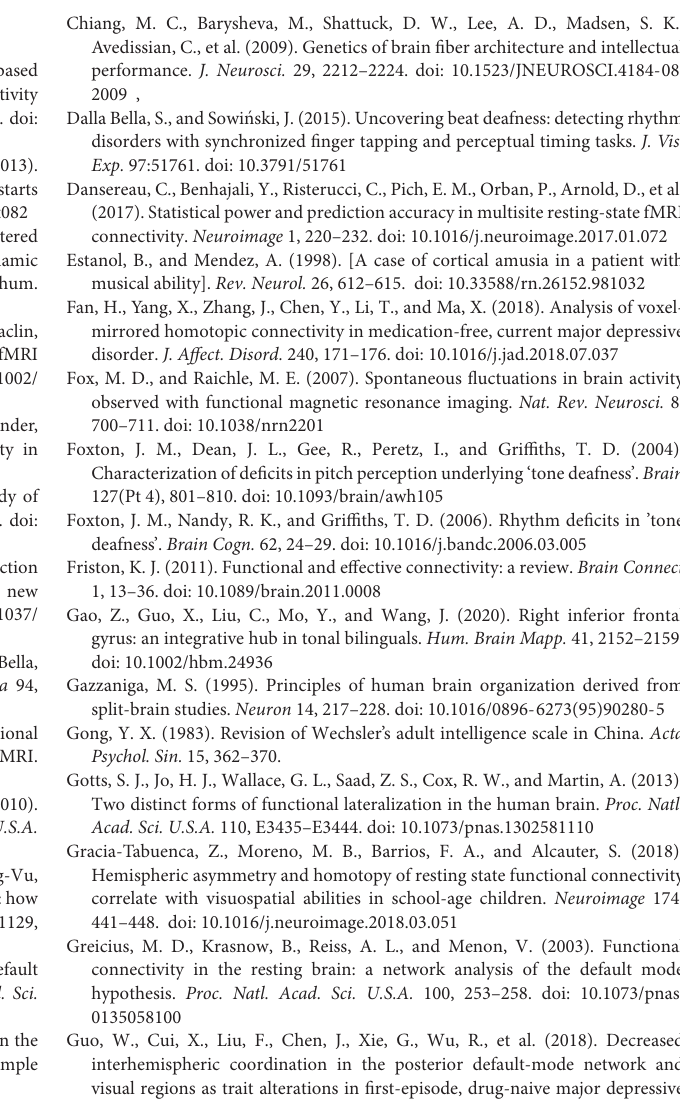
Supplementary Figure 1 | Correlation analyses between the mean VMHC value of pSTG and MBEA scores in control group. Supplementary Figure 2 | Correlation analyses between the mean value of PCC and MBEA scores in control